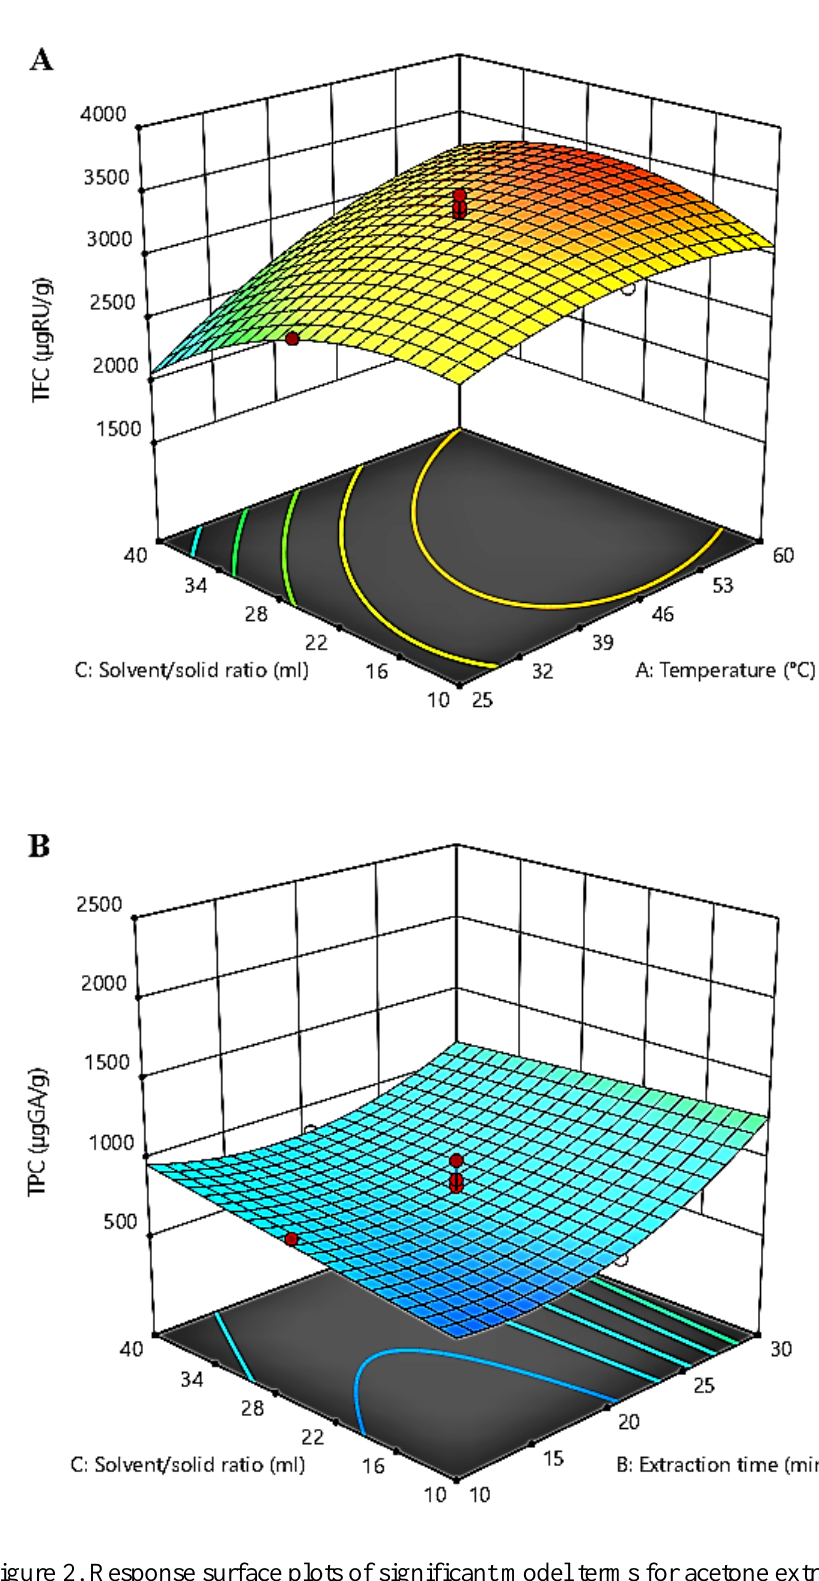
Figure 2. Response surface plots of significant model terms for acetone extract: A − TFC (total flavonoid content) and effect of extraction temperature and solid/solvent ratio, and B − TPC (total phenolic content) and effect of extraction time and solid/solvent